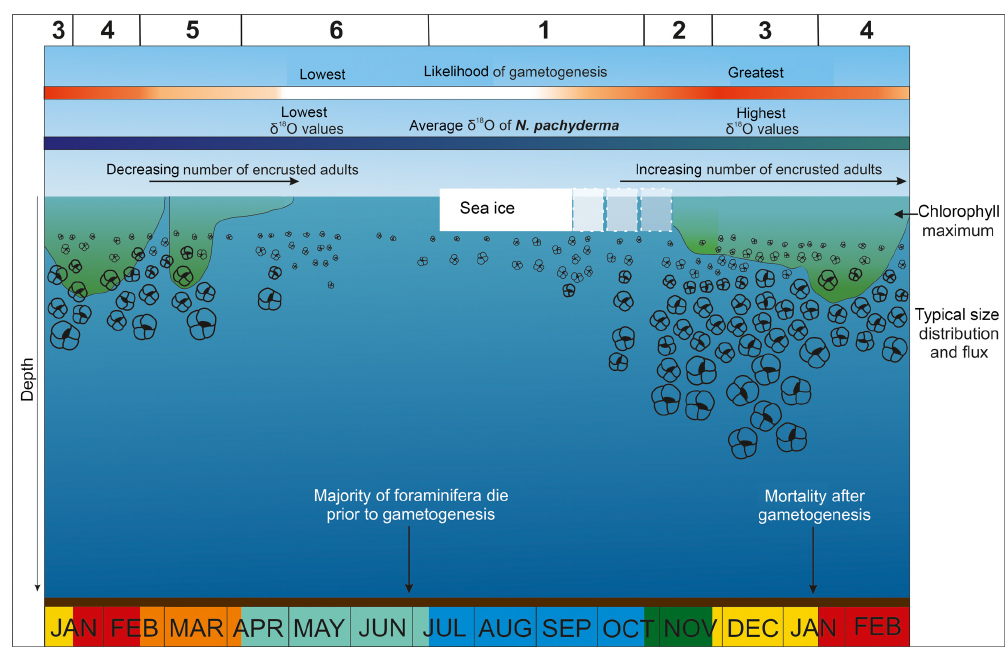
Figure 9. Summary schematic of a typical year at the Palmer sediment trap site. Colours illustrate the six phases of the annual cycle described in the main